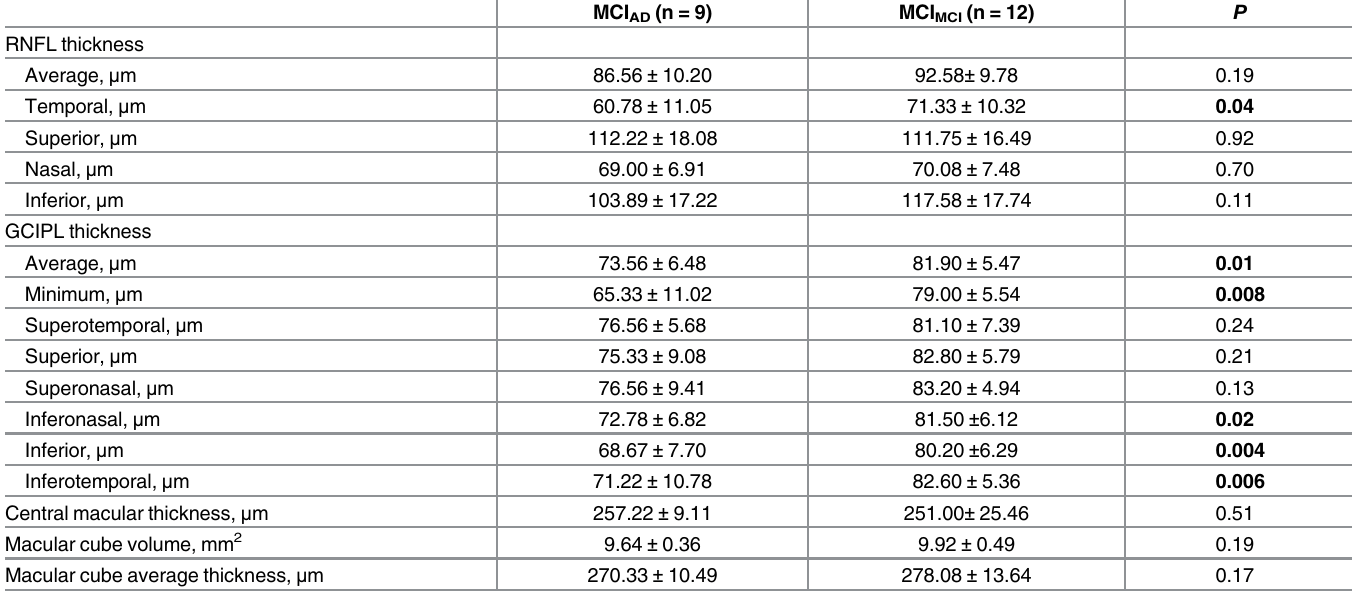
Table 4. Comparisons of the baseline thicknesses of retinal nerve fiber layer (RNFL) and ganglion cell inner plexiform layer (GCIPL) between patients with mild cognitive impairment who converted to Alzheimer ’ s disease (MCI AD ) and stable MCI patients (MCI MCI ).